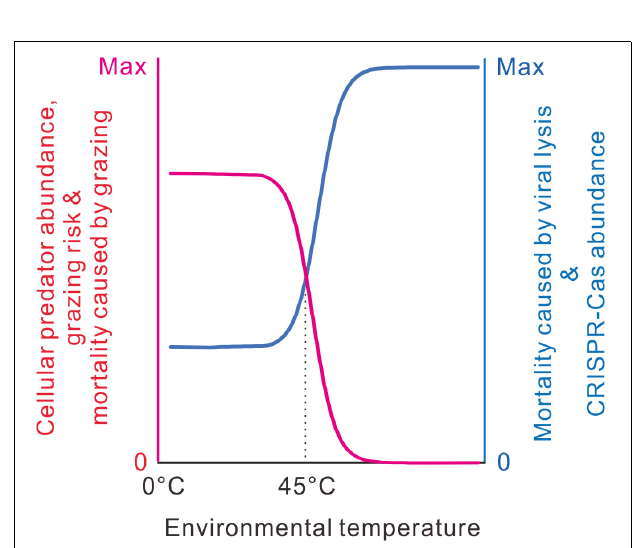
FIGURE 9 | A model for the thermal distribution of bacterial CRISPR-Cas systems. At low temperatures, the evolution of CRISPR-Cas systems is limited by the grazing pressure of cellular predators. At around 45 ◦ C, cellular predator abundance decreases abruptly with environmental temperature, so viral lysis takes more in bacterial mortality, and the requirement of the immune function increases substantially. When cellular predators almost disappear at high temperatures, mortality results primarily from viral lysis; most bacteria evolve the highest antivirus